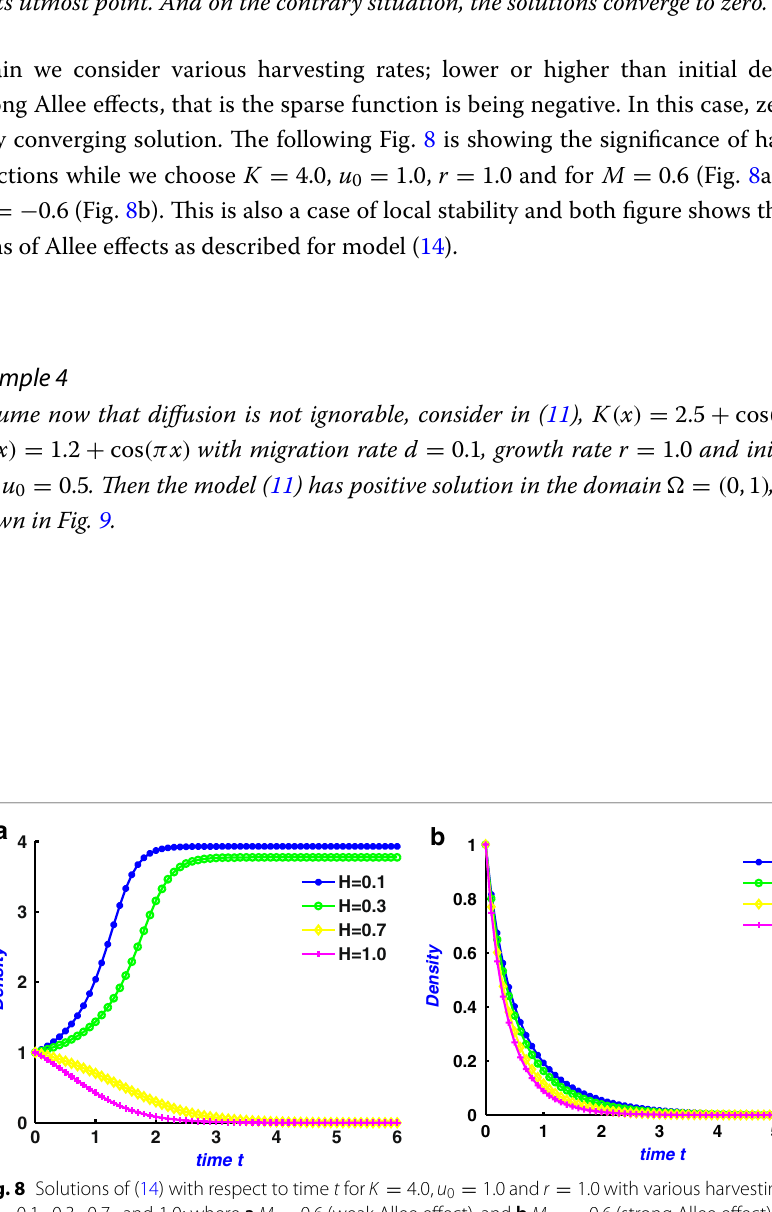
Fig. 8 Solutions of (14) with respect to time t for K H 0.1, 0.3, 0.7, and 1.0 ; where a M =